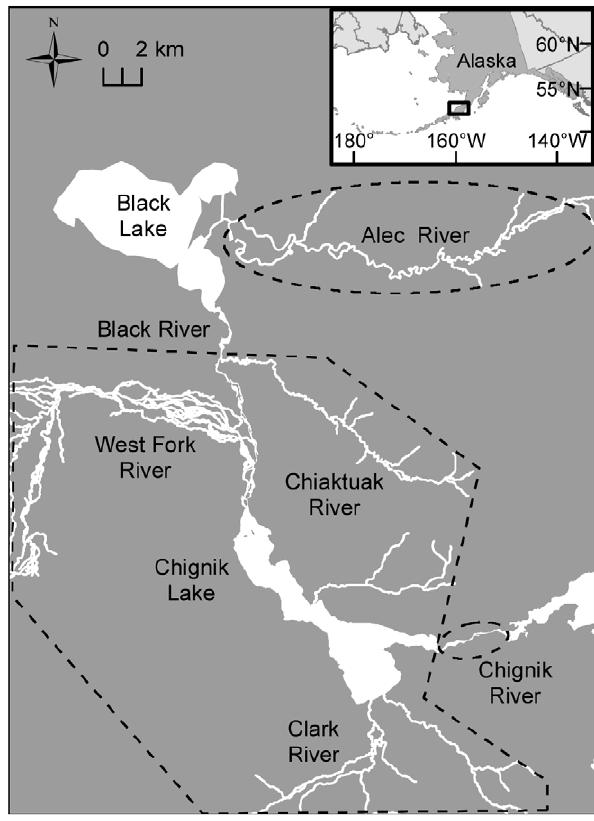
Figure 1. Map of the Chignik watershed. The spawning habitat encompassed within each stock group is outline by a dashed polygon. Black River spawning populations occur primarily in the Alec River and adjacent Fan Creek (not shown). Chignik Lake spawning populations include the West Fork and Chiaktuak Rivers, Chignik Lake beaches, Clark River and other minor tributaries. The Chignik River spawning population occurs downstream of the Chignik Lake outlet.